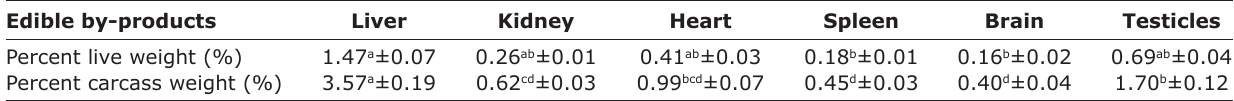
Table-1: Least square means (±SE) of percent live weight and percent carcass weight of different edible by-products of Barbari kids Edible by-products